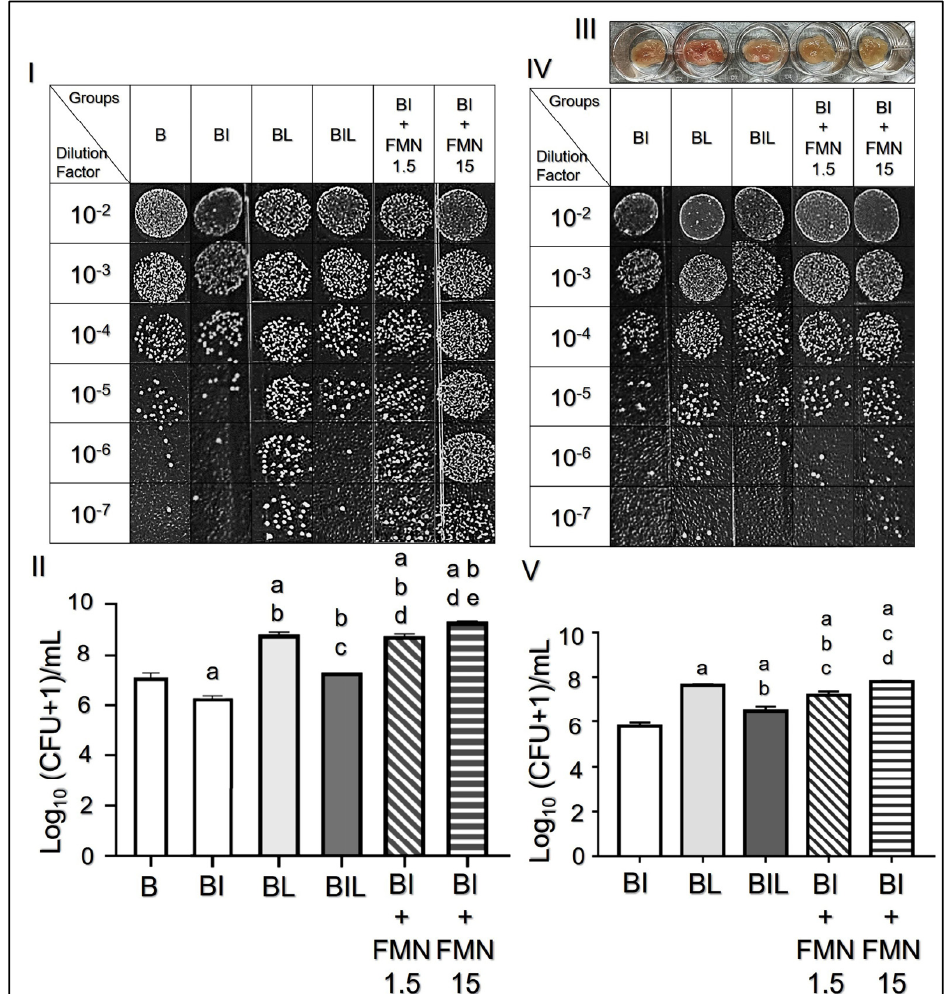
Figure 4. Evaluation of the adhesion capability of L. plantarum MA to the intestine in vitro and ex vivo. ( I ) Photographic images of the colonies of cell-attached L. plantarum MA grown on the MRS agar plates for 24 h. The bacteria were co-cultured with the Caco-2 cells in the presence of nothing (B), roseoflavin (BI), lactulose (BL), roseoflavin + lactulose (BIL), roseoflavin + 1.5 µM FMN (BI + FMN 1.5), or roseoflavin + 15 µM FMN (BI + FMN 15) for 24 h, followed by isolation from the cells for the colony assay. ( II ) Quantitative analyses of the MPI of L. plantarum MA shown in ( I ). Values are the mean ± SD (n = 3). a, b, c, d, and e represent p < 0.05 compared to the groups treated with B, BI, BL, BIL, and BI + FMN 1.5, respectively. ( III ) Photographs of the cecum used in the adhesion assay ex vivo. ( IV ) Photographic images of the colonies of the cecum-attached L. plantarum MA grown on the MRS agar plates for 24 h. L. plantarum MA were co-cultured with cecum in the presence of roseoflavin (BI), lactulose (BL), roseoflavin + lactulose (BIL), roseoflavin + 1.5 µ M FMN (BI + FMN 1.5), or roseoflavin + 15 µ M FMN (BI + FMN 15) for 24 h, followed by isolation form the cecum for the colony assay. ( V ) Quantitative analyses of the MPI of L. plantarum MA shown in ( IV ). Values are the mean ± SD (n = 3). a, b, c, and d represent p < 0.05 compared to the groups treated with BI, BL, BIL, and BI + FMN 1.5,